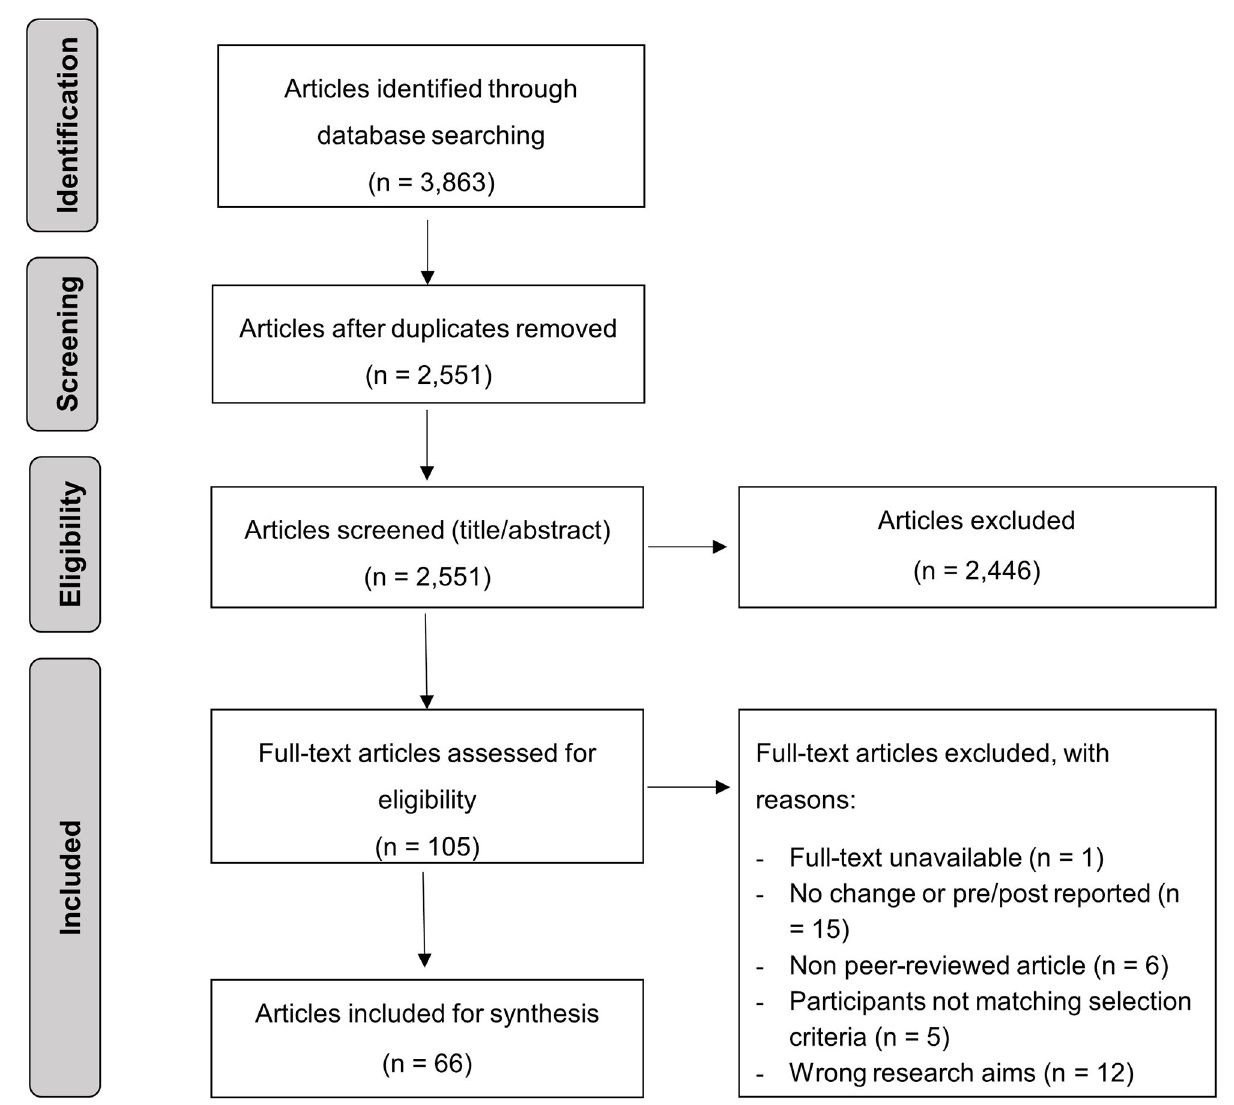
Fig 1. Flowchart of screening process and search